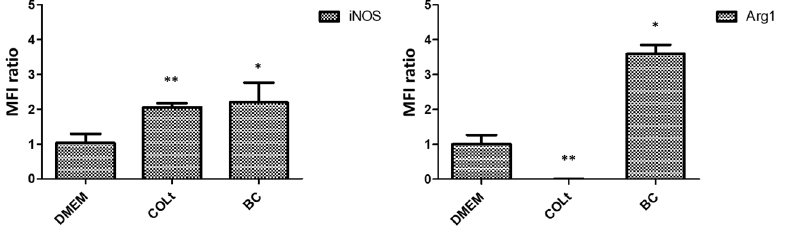
Figure 7. Expression of inducible nitric oxide synthase (iNOS) and arginase-1 (Arg1) secreted by macrophages cultured on bacterial cellulose (BC) scaffold, collagen total type material (COLt), or in DMEM for 24 h (* p < 0.05; ** p < 0.01) .